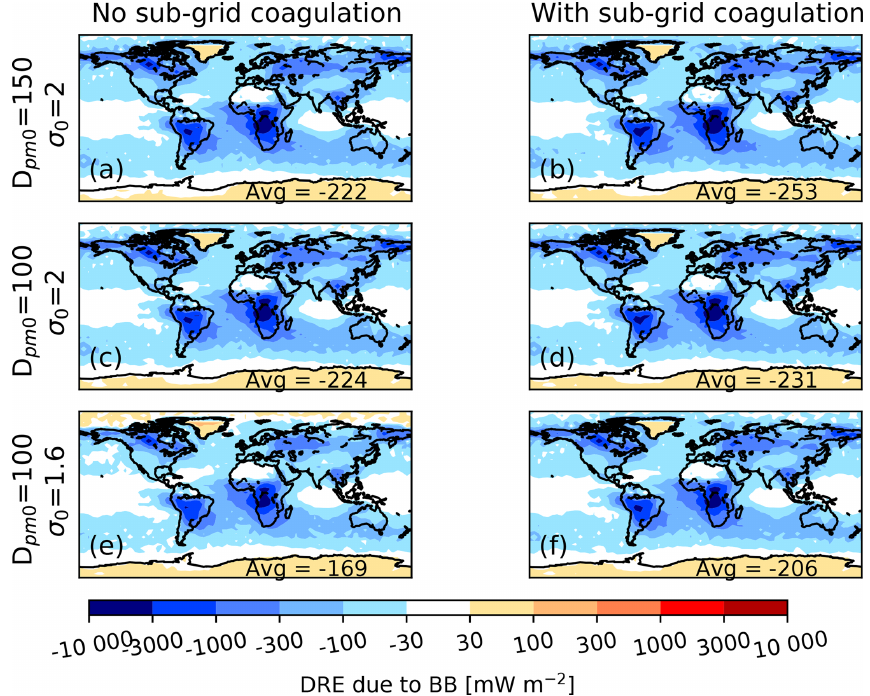
Figure 7. All-sky direct radiative effect (DRE) due to biomass burning aerosols using GFED emissions and the external mixing assumption. Panels (a) , (c) , and (e) are without sub-grid coagulation ( D150_noSubCoag , noSubCoag , and s1.6_noSubCoag , respectively). Panels (b) , (d) , and (f) are with sub-grid coagulation ( D150_SubCoag , SubCoag , and s1.6_SubCoag , respectively). Panels (a) and (b) have an emitted median diameter of 150nm and an emitted modal width of 2. Panels (c) and (d) have an emitted median diameter of 100nm and an emitted modal width of 2. Panels (e) and (f) have an emitted median diameter of 100nm and an emitted modal width of 1.6. The number in the bottom right of each panel is the global mean DRE value (mWm − 2